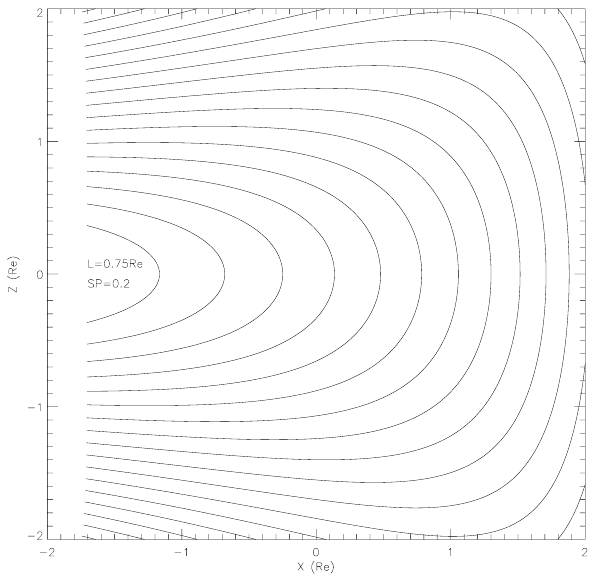
Fig. 1. An example unstable domain ( L = 0 . 75 R E , SP=0.2).